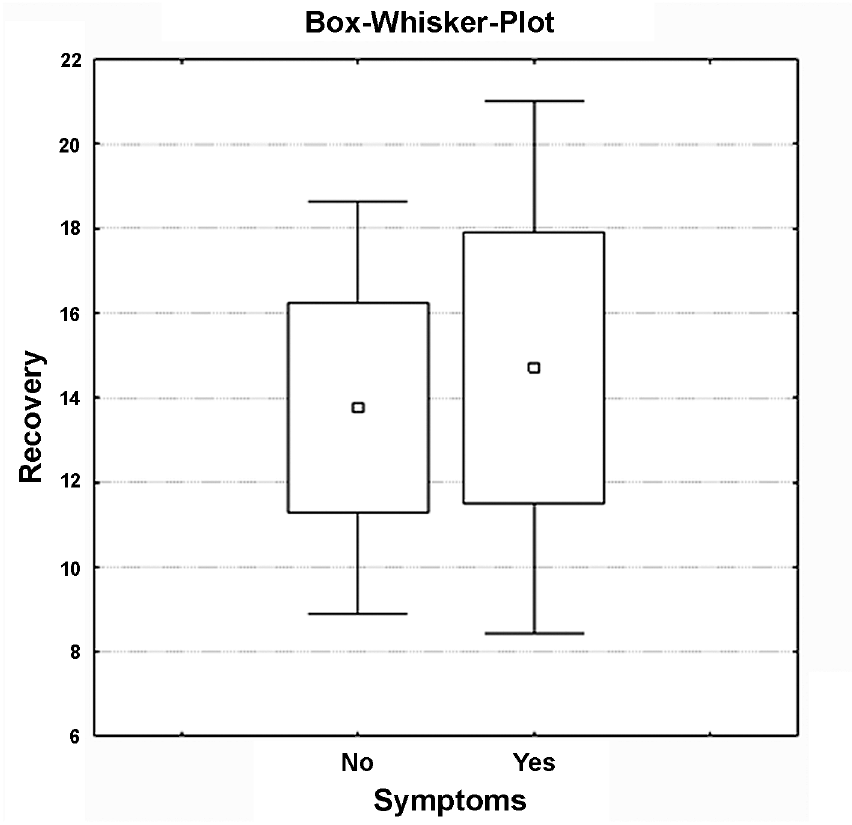
Figure 3 – Student’s-t test. Symptomatic patients exhibited a slight but insignificant tendency of prolonged recovery